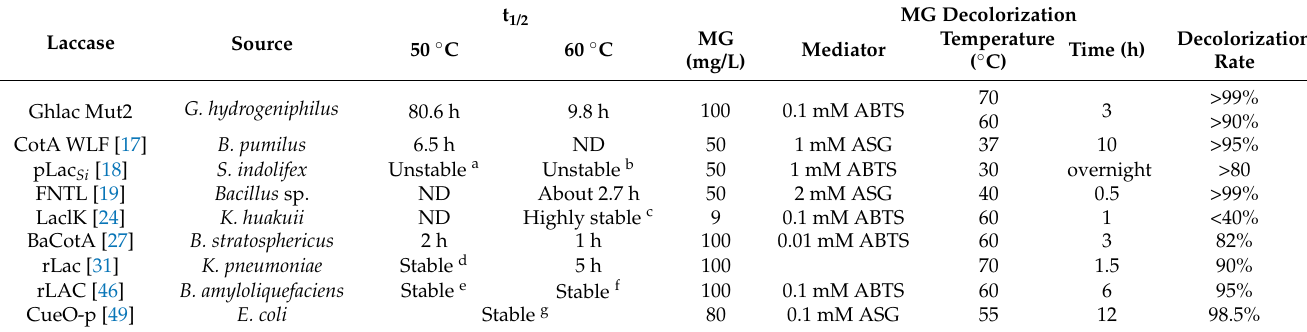
Table 1. Comparison of the thermostability and MG decolorization ability of bacterial